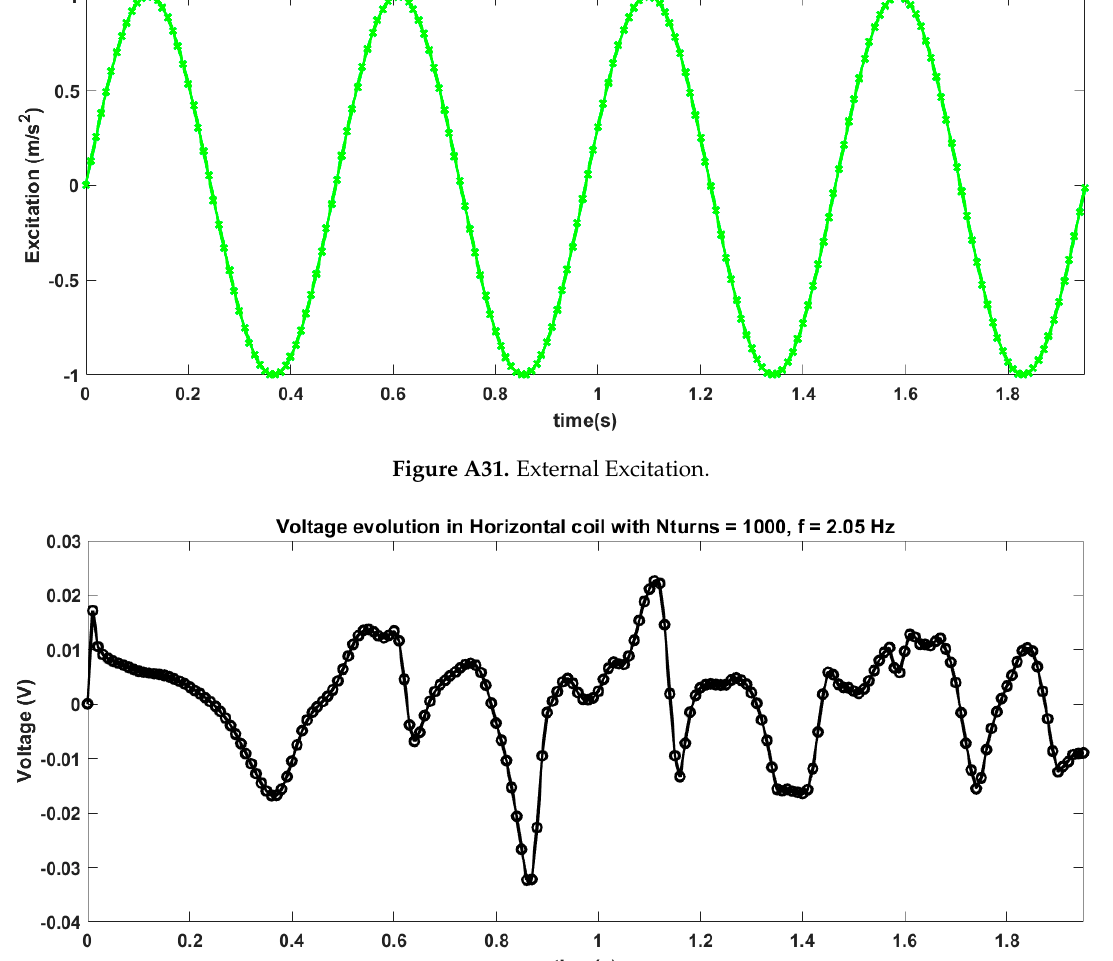
Figure A32. Voltage evolution for horizontal coil with 1000 turns for case 7 of magnet arrangement and 2.05 Hz frequency of excitation.